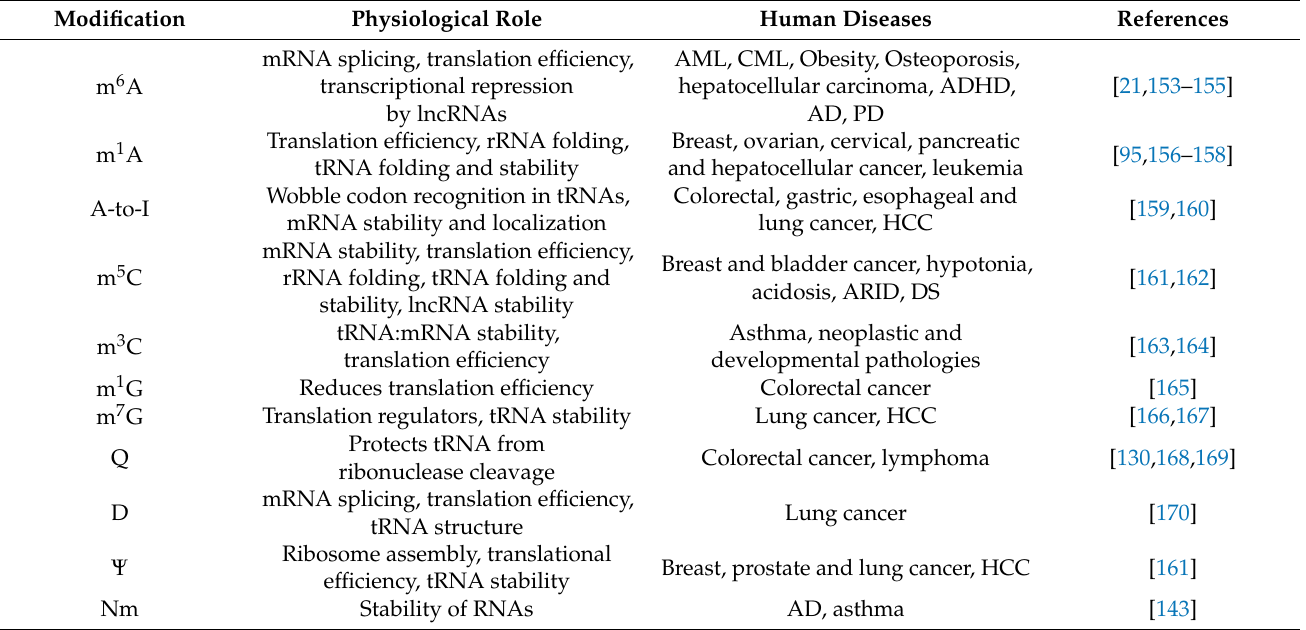
Table 4. Regulatory roles of RNA modifications in various human diseases. Modification Physiological Role Human